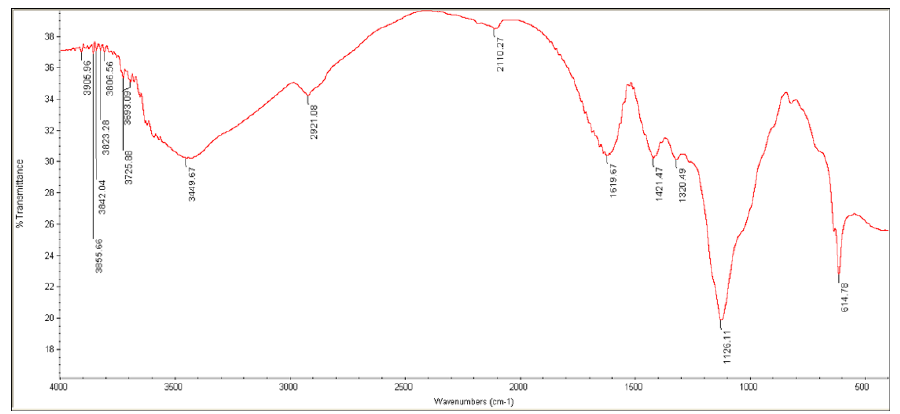
Figure 2. Morphology of microcapsules under the scanning electron microscope .